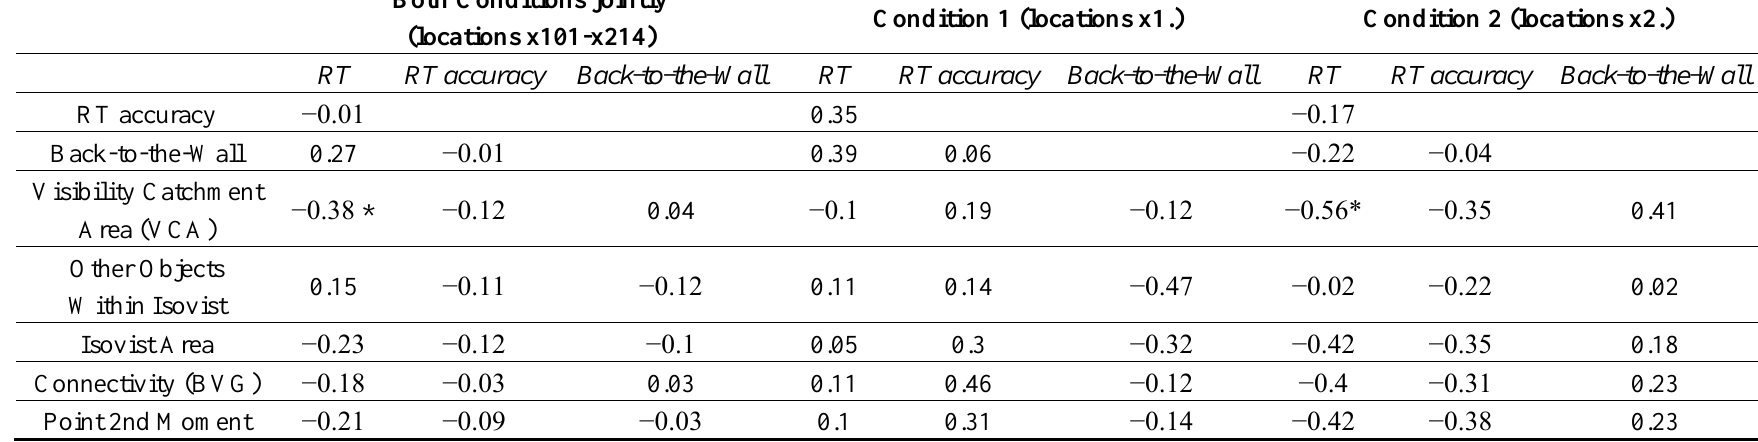
Table 1. Correlation matrices for location-oriented